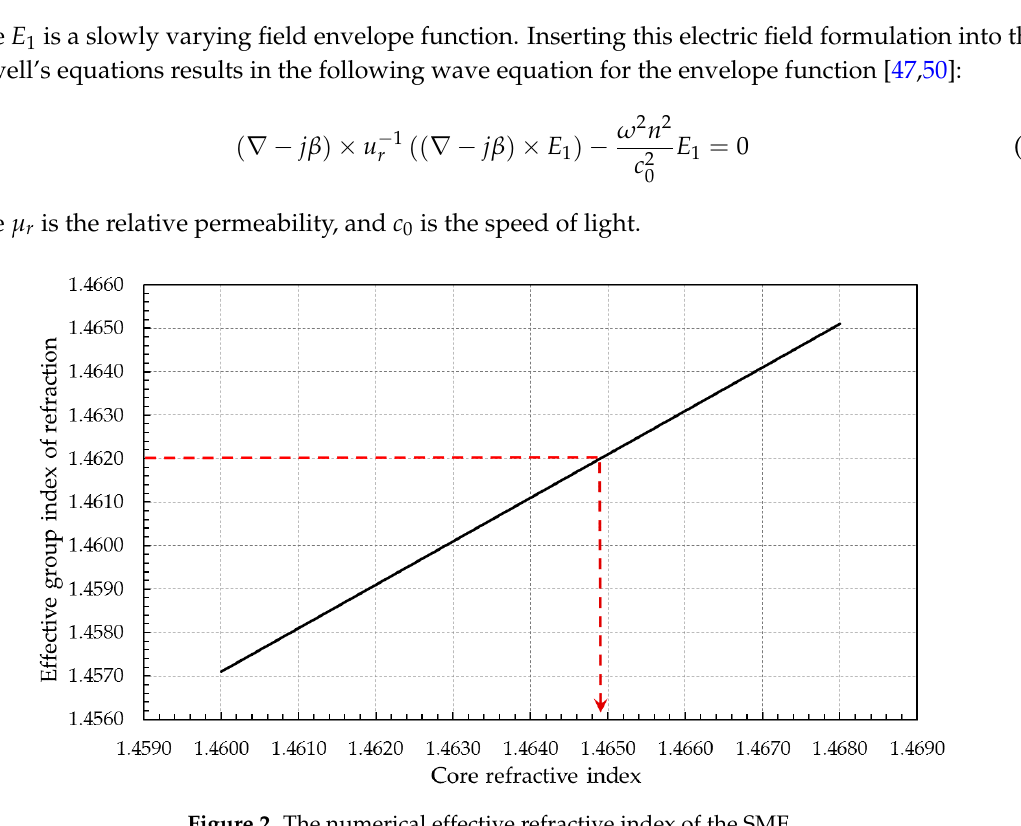
Figure 2. The numerical effective refractive index of the SMF.